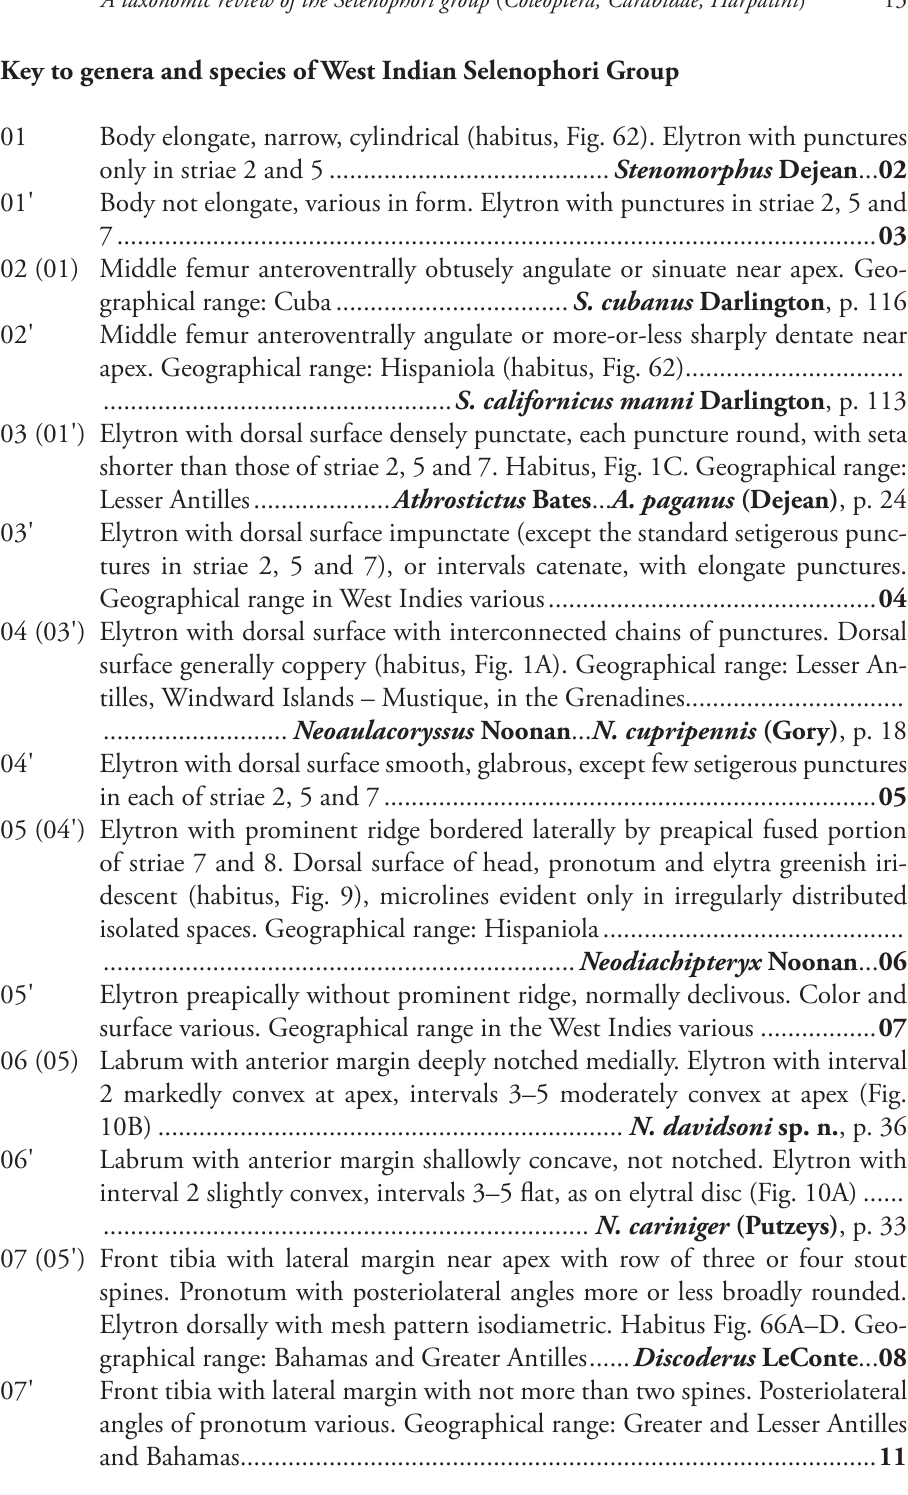
05' Elytron preapically without prominent ridge, normally declivous. Color and surface various. Geographical range in the West Indies various ................. 07 06 (05) Labrum with anterior margin deeply notched medially. Elytron with interval 2 markedly convex at apex, intervals 3–5 moderately convex at apex (Fig. 06' Labrum with anterior margin shallowly concave, not notched. Elytron with interval 2 slightly convex, intervals 3–5 flat, as on elytral disc (Fig. 10A) ...... 07 (05') Front tibia with lateral margin near apex with row of three or four stout spines. Pronotum with posteriolateral angles more or less broadly rounded. Elytron dorsally with mesh pattern isodiametric. Habitus Fig. 66A–D. Geo- graphical range: Bahamas and Greater Antilles ...... Discoderus LeConte ... 08 07' Front tibia with lateral margin with not more than two spines. Posteriolateral angles of pronotum various. Geographical range: Greater and Lesser